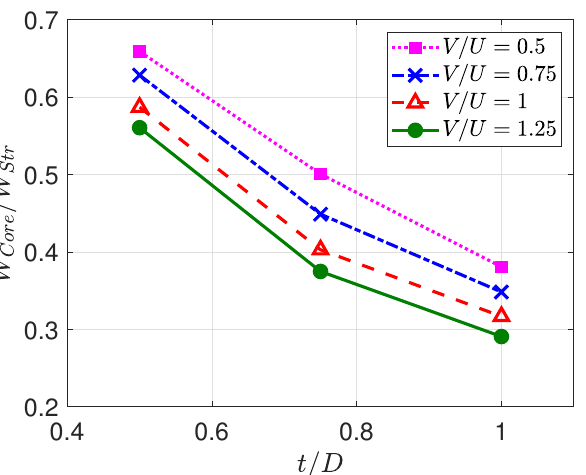
Figure 7. Maximum width of the core to maximum width of the overall strand for different operating parameters as a function of t / D for different V / U .